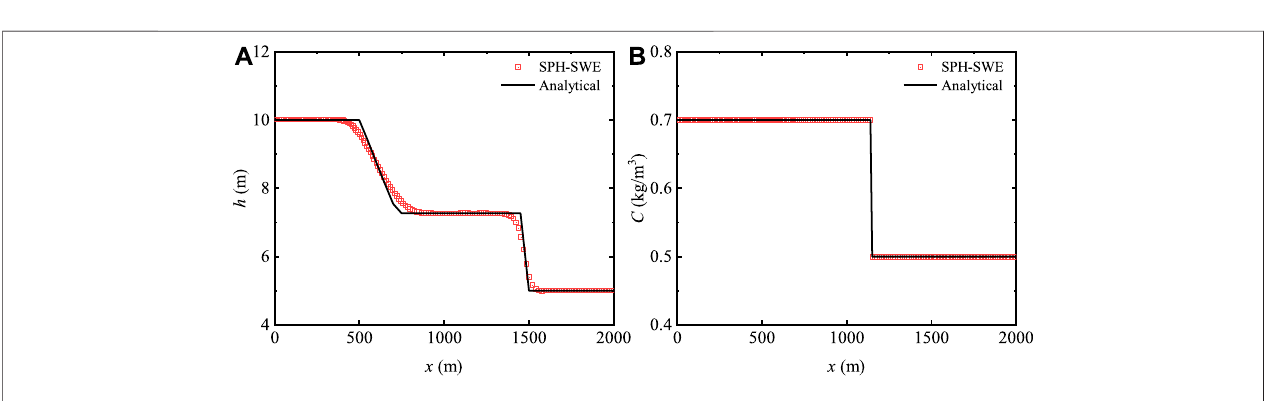
Frontiers in Environmental Science |